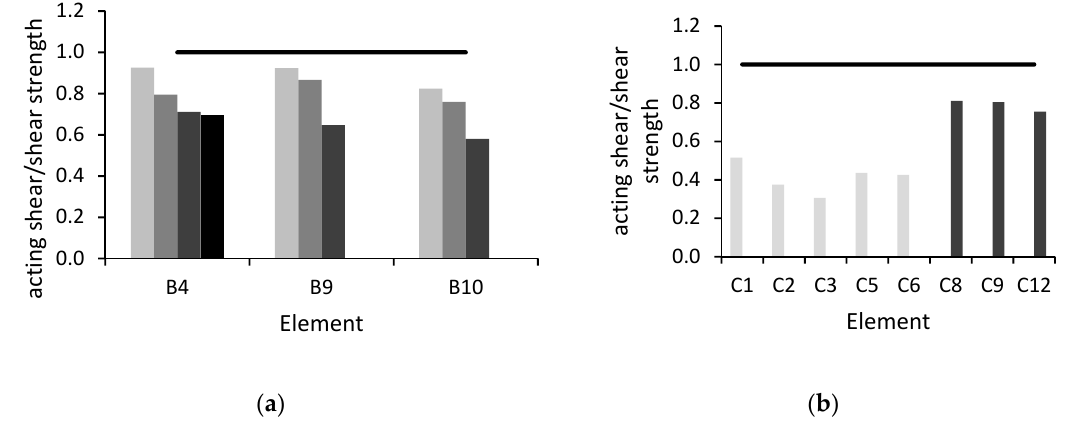
Figure 12. Shear verifications after retrofit of: ( a ) beams and ( b ) columns.